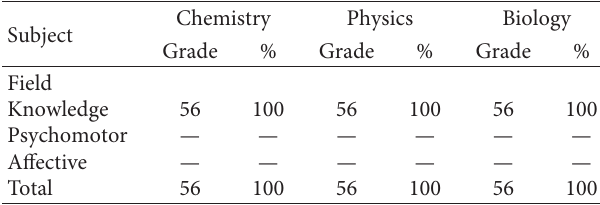
Table 3: Final examinations’ question distribution for chemistry, physics, and biology based on grades for each set of objectives.